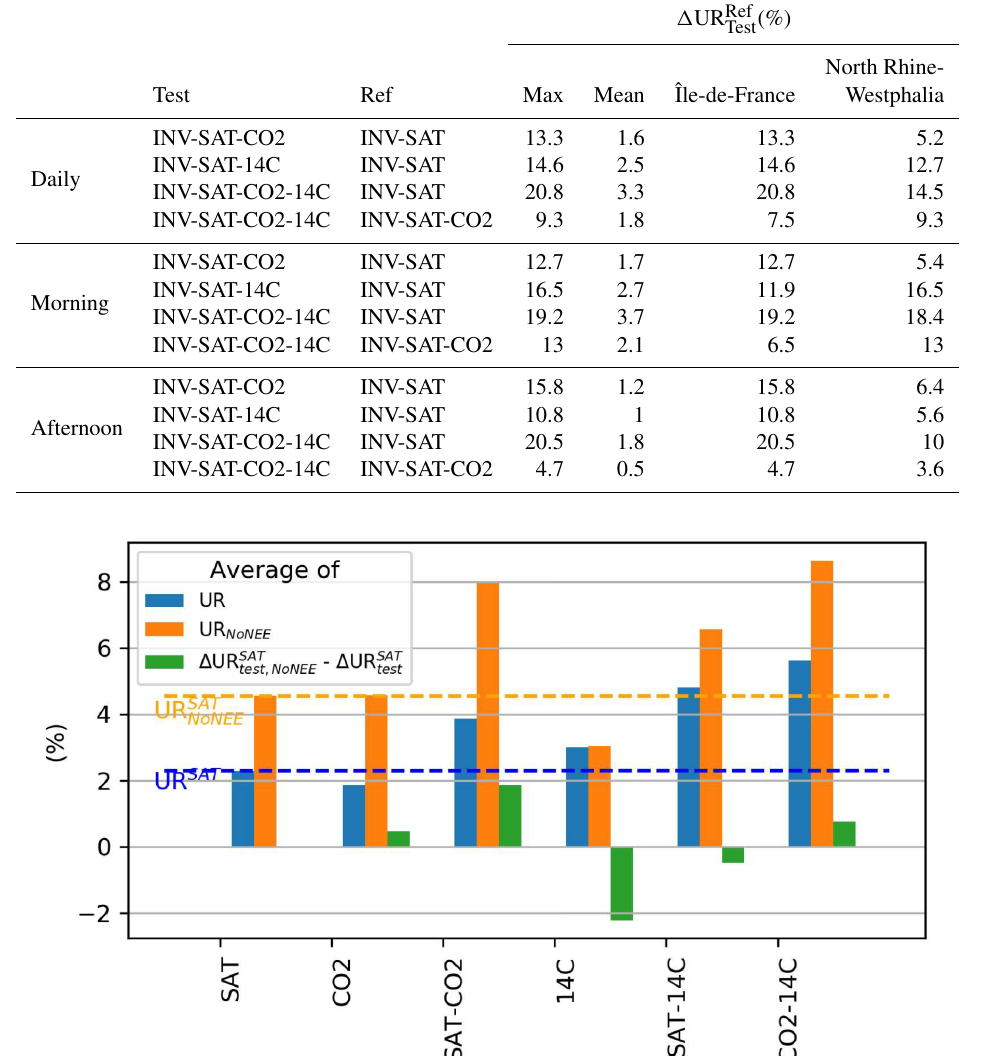
on 24h, morning, and afternoon FF regional Test